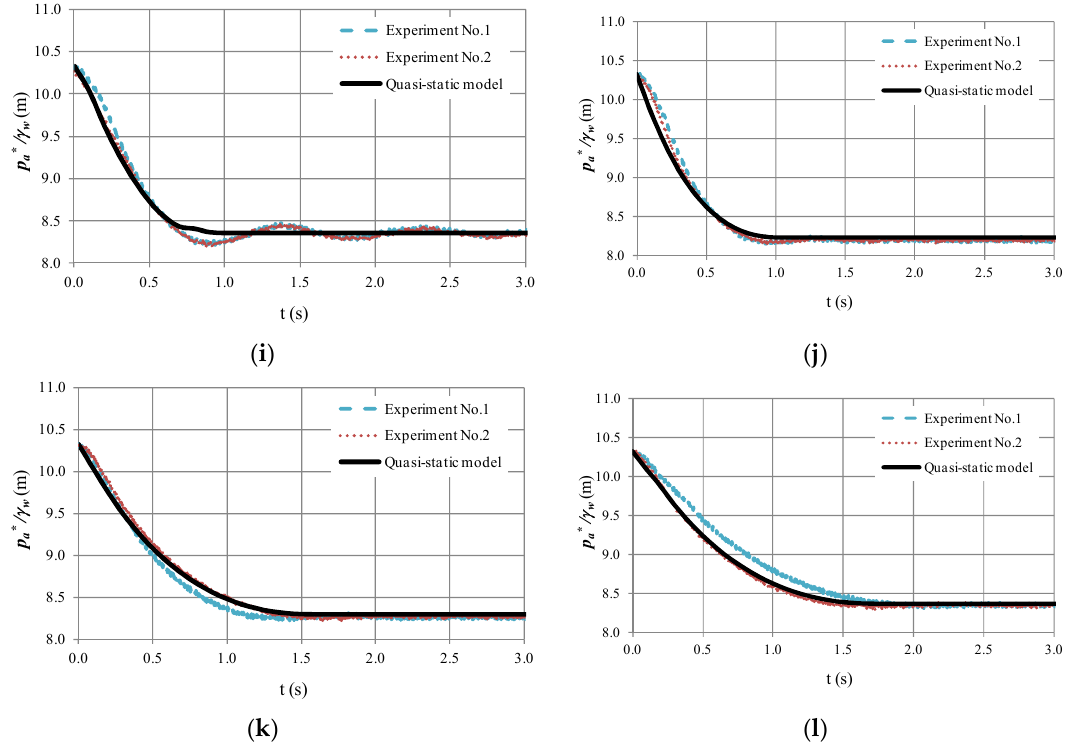
Figure 5. Comparison between computed and measure of air pocket pressure patterns: ( a ) Run No. 1; ( b ) Run No. 2; ( c ) Run No. 3; ( d ) Run No. 4; ( e ) Run No. 5; ( f ) Run No. 6; ( g ) Run No. 7; ( h ) Run No.